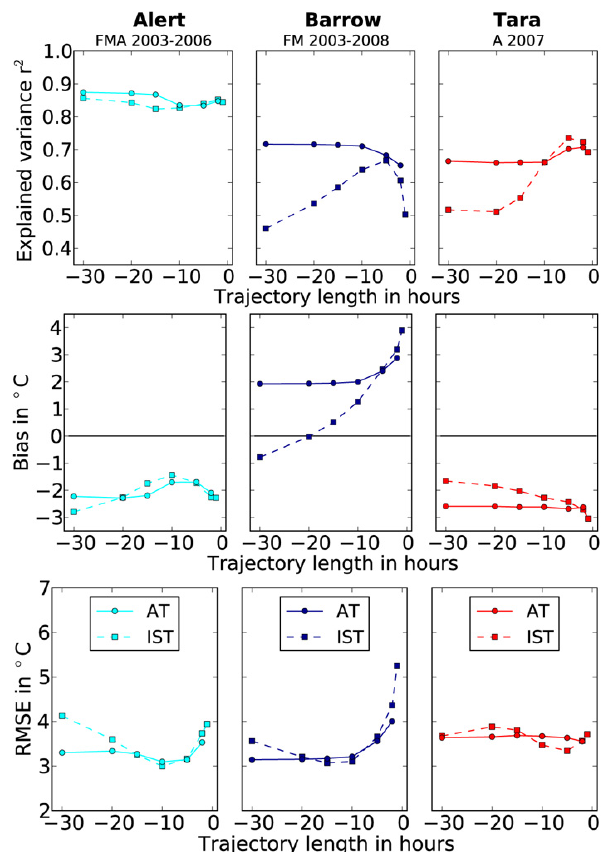
Fig. 10. Explained variances (upper), bias (middle) and RMSE (lower) for Alert, Barrow and Tara (JAA) as a function of trajec- tory length using the IST and AT methods, with 350m BL depth in the